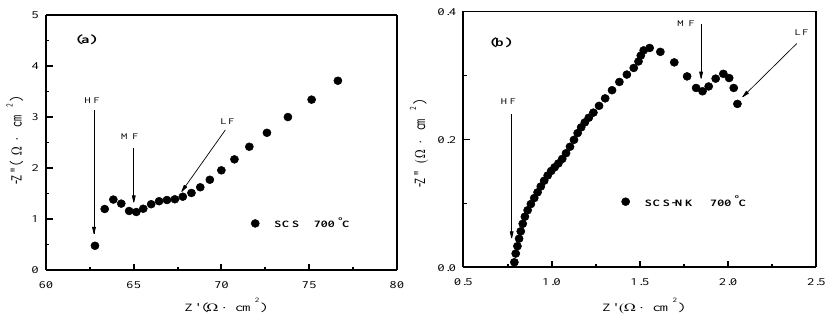
Figure 7. The impedance spectra of the single cells under open-circuit condition at 700 °C. ( a ) SrCe 0.9 Sm 0.1 O 3-α (SCS) and ( b ) SrCe 0.9 Sm 0.1 O 3-α -NaCl-KCl (SCS-NK).